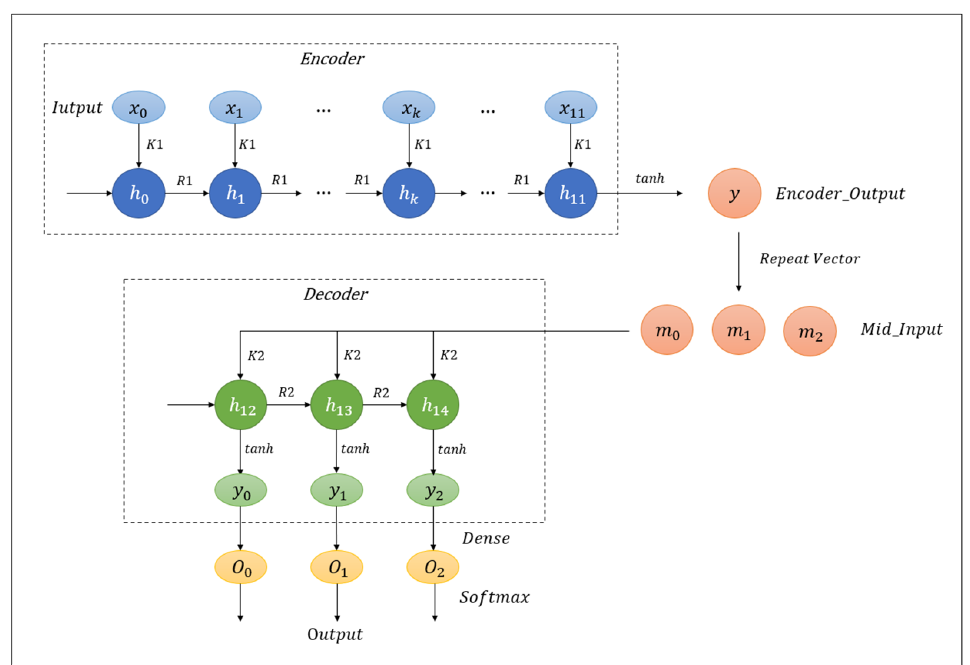
Figure 3. Time series expansion model of the recurrent neural network (RNN).